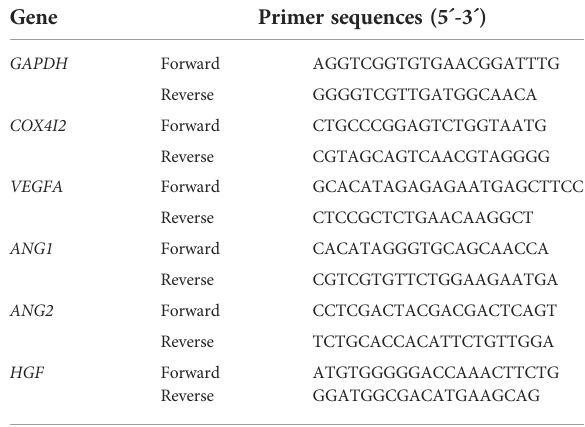
TABLE 2 Primers used for